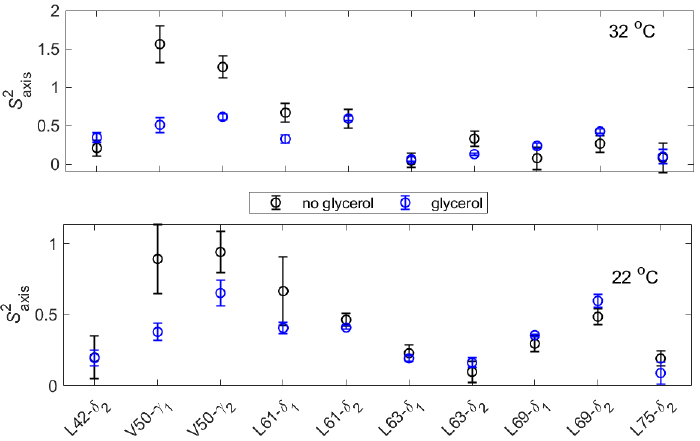
Figure 9. Comparison of methyl axis order parameters 𝑆 𝑎𝑥𝑖𝑠2 in the perdeuterated/LV protonated sample at 32 °C and 22 °C in absence of glycerol-d8 (black circles) and in the presence of 28% w/w glycerol (blue circles) versus site identity. The fits were done according to Equation (4) with 𝜏 𝑓 fixed at 500 ps.